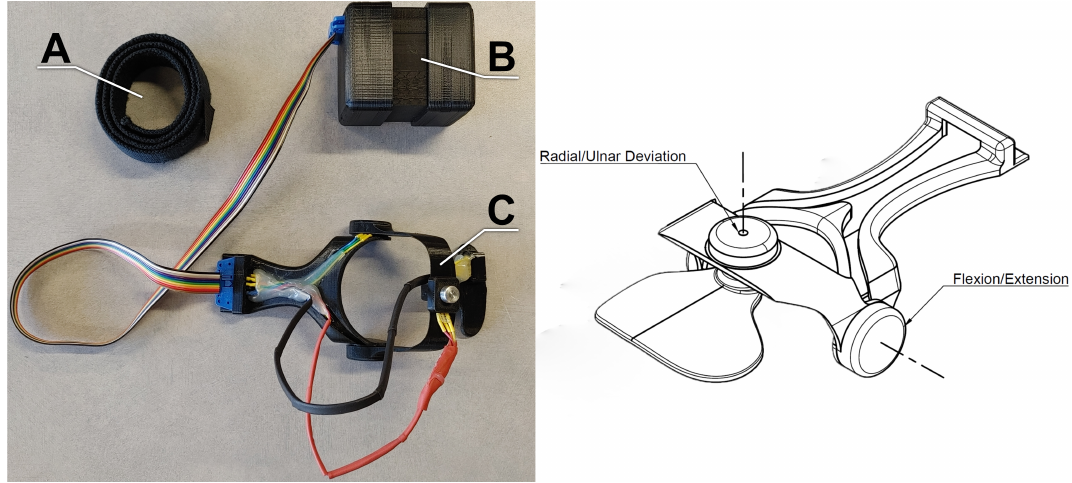
Figure 1. The 3D printed wearable device with wrist strap ( A ), datalogger ( B ), and transducer ( C ).